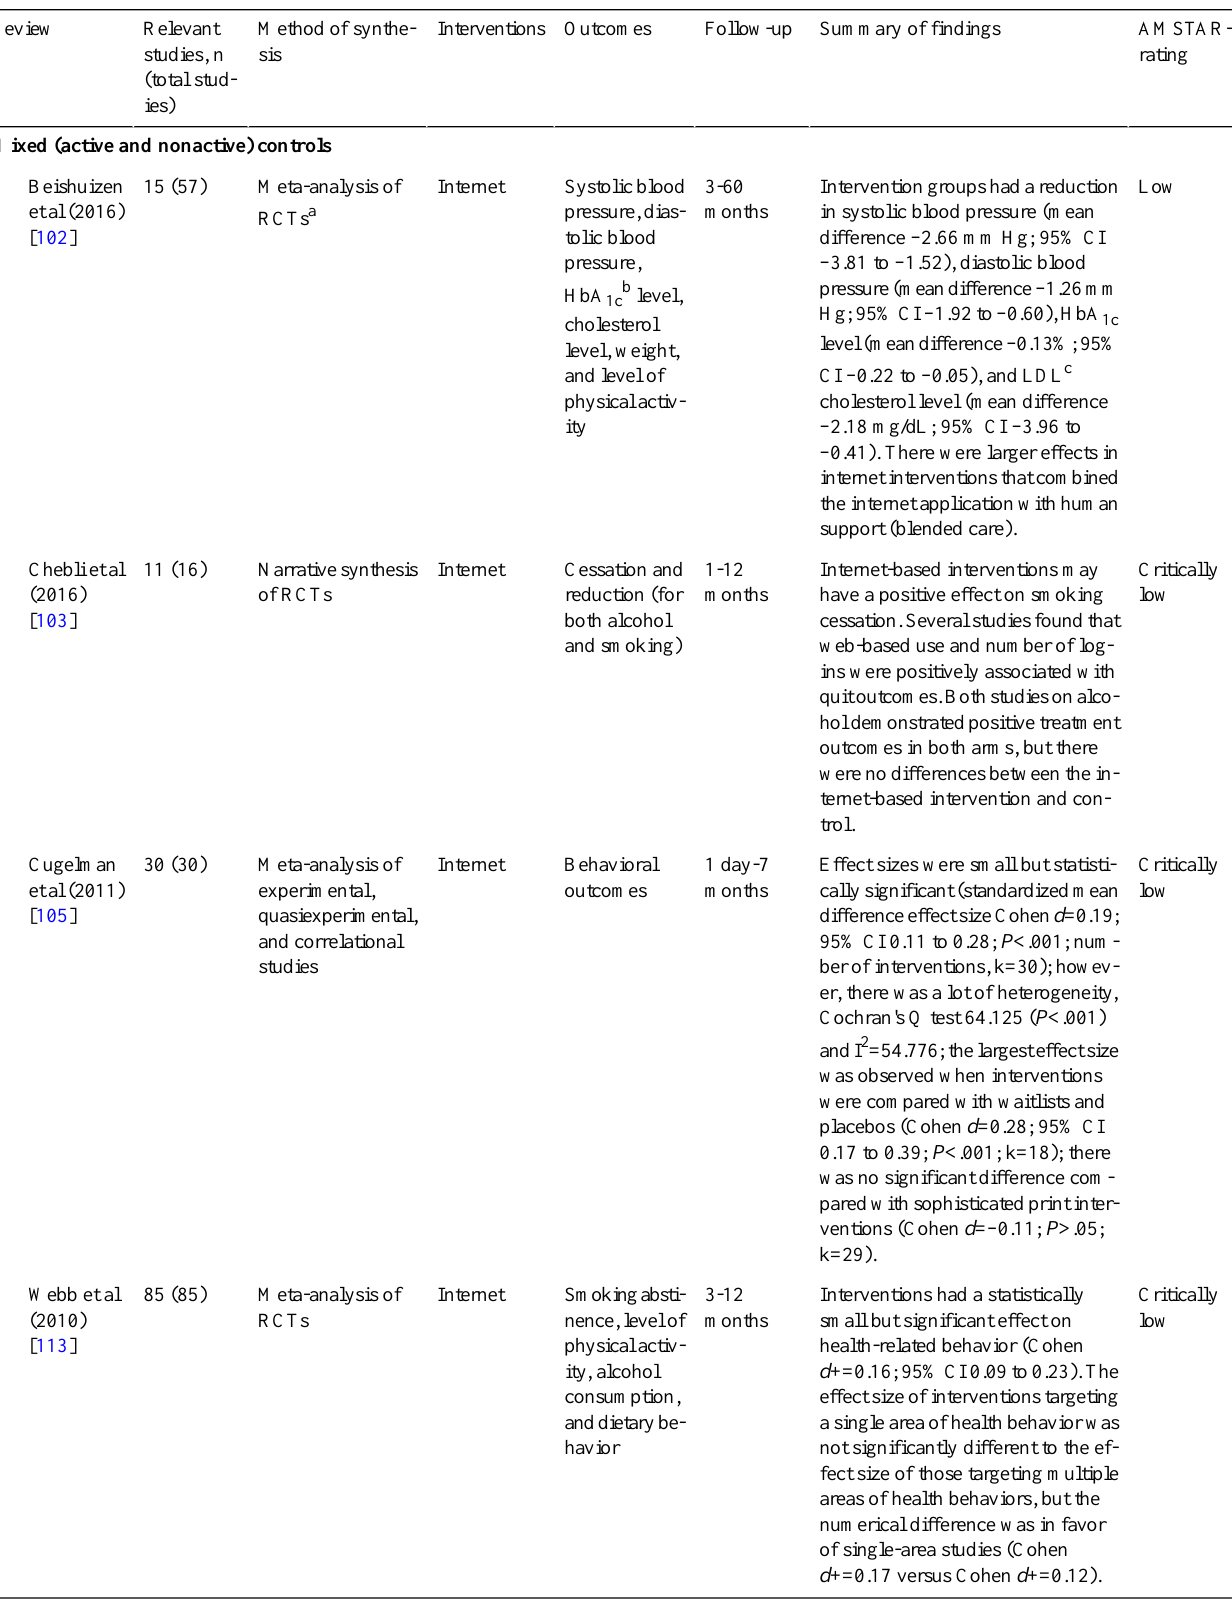
Table 8. Effectiveness of digital interventions on other combinations of outcomes, sorted by controls and further sorted by intervention